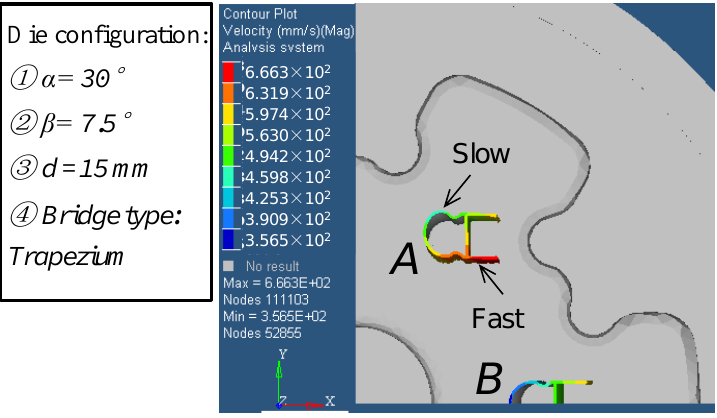
Figure 8. The distribution of the relative exit velocity.